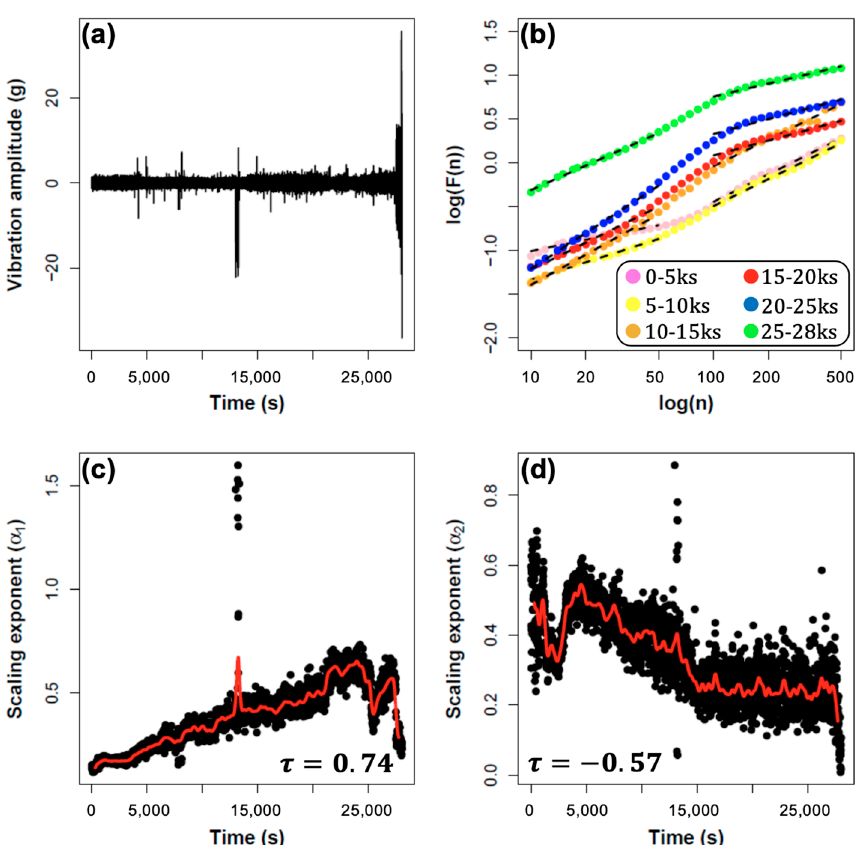
Figure 7. The vertical bearing vibration signal (data set 1_1) and its corresponding fluctuation functions and scaling exponents: ( a ) the vertical vibration signal; ( b ) the average fluctuation function vs. the box size over several segments of the vertical vibration signal; ( c ) the scaling exponents ( α 1 ) inside 2560-sample windows of the vertical vibration signal toward the bearing failure; ( d ) the scaling exponents ( α 2 ) inside 2560-sample windows of the vertical vibration signal toward the bearing failure.